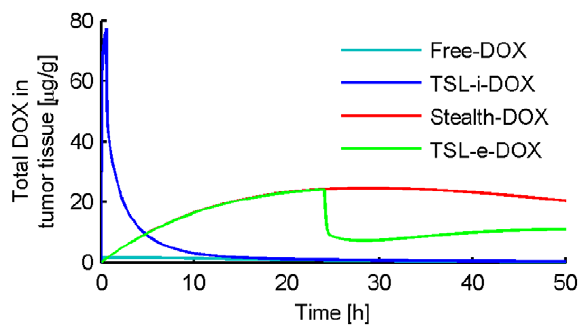
Figure 3. Liposomal DOX plasma concentration for Stealth liposomes and TSL-i over a time period of 12 h. Shorter TSL-i half- life results from reduced stability at body temperature compared to Stealth liposomes.